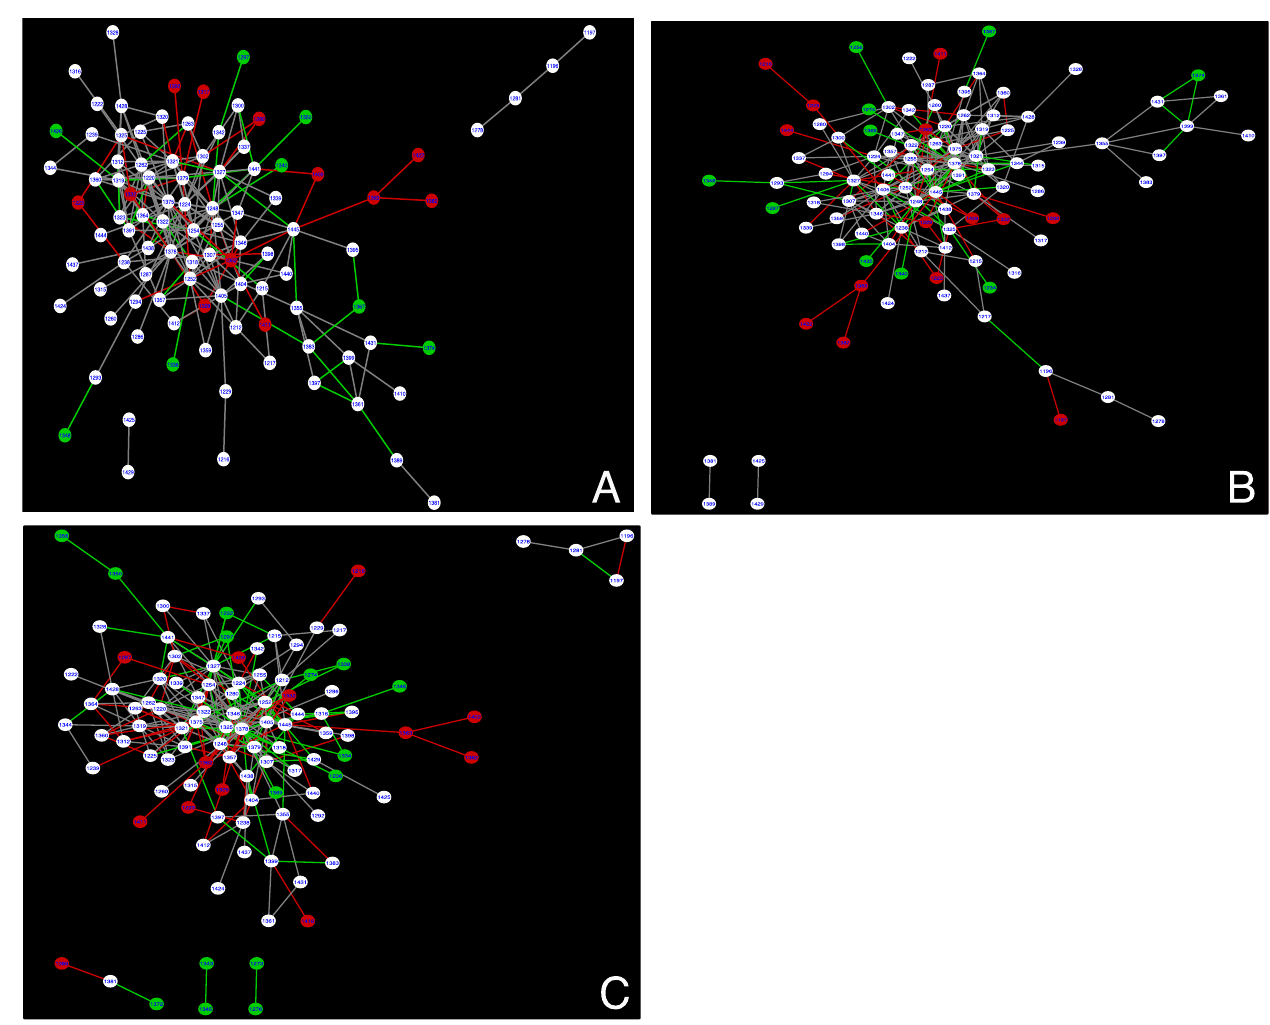
Fig 8. ELSC analysis of Wildtype MSA subsets. Overlay of cytoscape maps for Wildtype (5,032) and (A) 2000, (B) 1000, and (C) 500 sequence MSA subsets, respectively. The original Wildtype MSA is colored red and the subset is colored green with overlapping nodes and edges colored white and grey, respectively. Maps are representative of analyses that were done in triplicate.